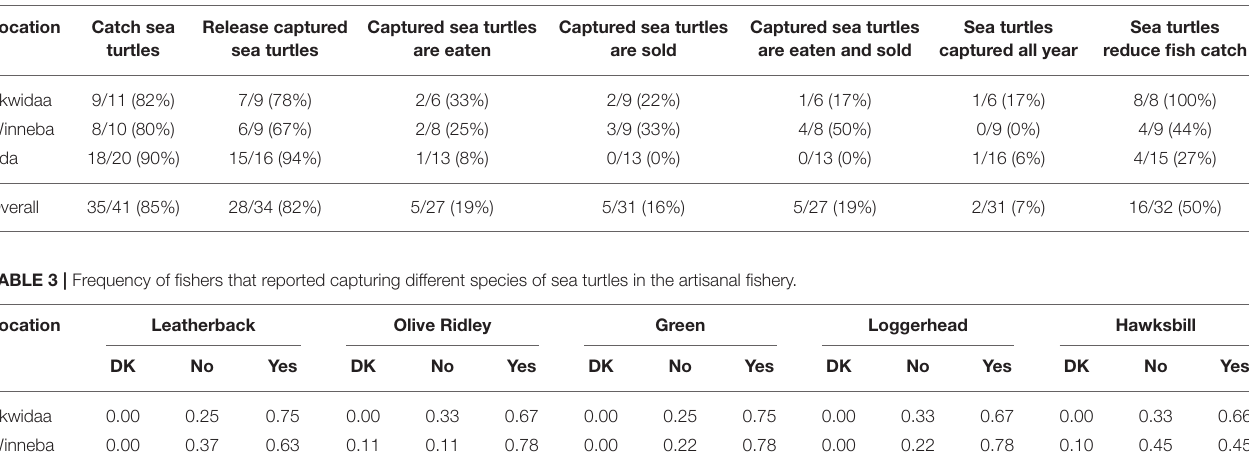
TABLE 2 | Responses from fishers when asked questions regarding their experiences with sea turtle captures in the artisanal fisheries of three communities in Ghana. Location